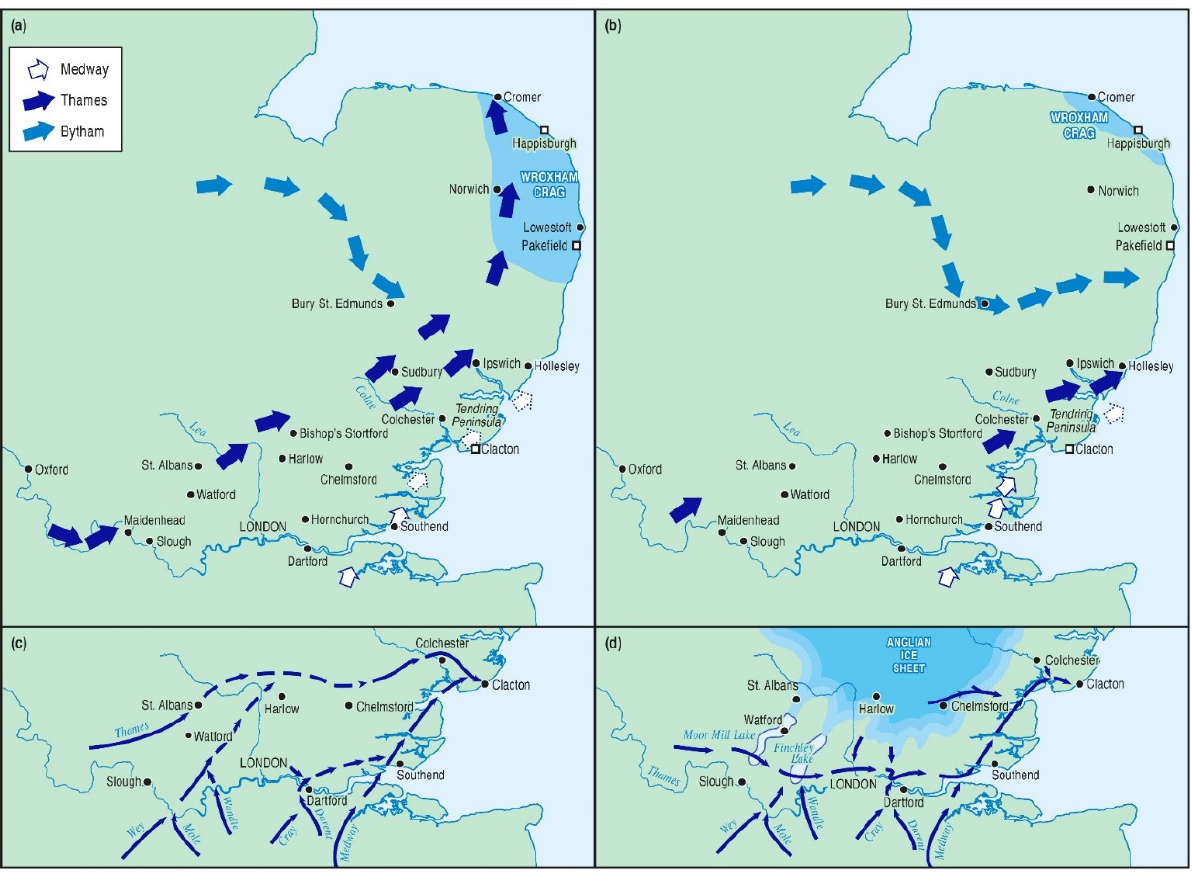
Figure 2. Evolution of Thames drainage (modified from [31]), showing the location of key sites. ( a )—Early Pleistocene (Westland Green Gravel); ( b )—early Middle Pleistocene (Waldringfield Gravel); ( c )—immediately prior to the arrival of Anglian (MIS 12) ice; ( d )—The Anglian glaciation and the initial diverted course.